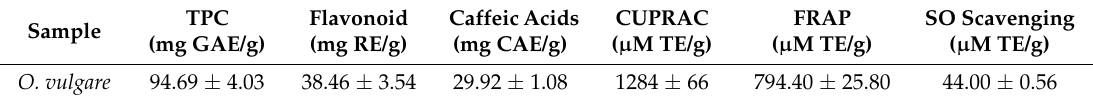
Table 2. Total polyphenol content and antioxidant activity of O. vulgare ssp. vulgare extract.